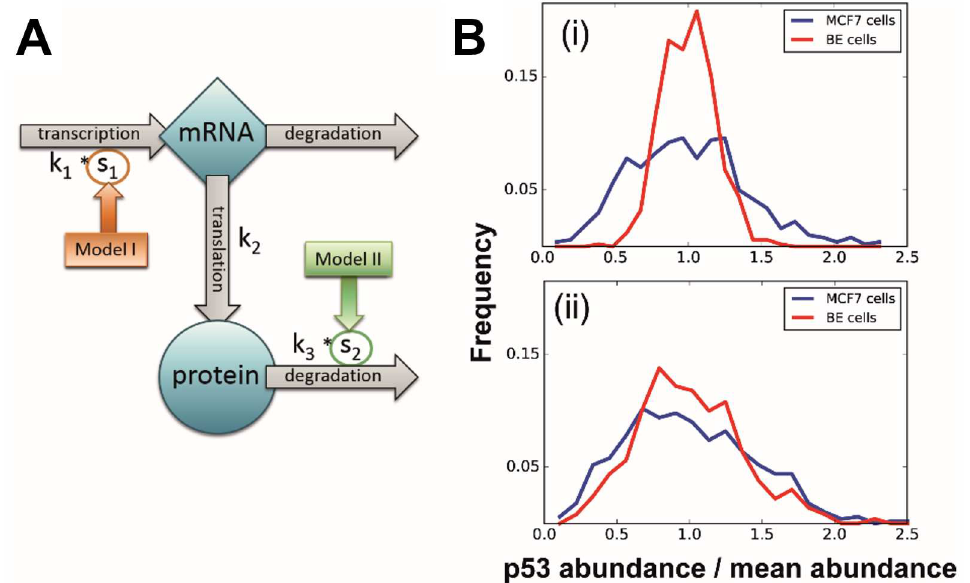
Fig 1. Schematics of the model and simulation examples of regulation strategies. (A) Schematic representation of the model of stochastic p53 protein expression. Blue shapes represent the two species, grey arrows the reactions modelledexplicitlyin our formalisation. Rate parameters corresponding to each reaction ( k 1, k 2, k 3 ) are indicatednext to their respectivereactions; the rate of mRNA degradationis assumed to be 1, and other rates are scaled accordingly. The two competingregulatorymodels are indicatedin dark orangeand green, with arrows pointingout the relevant reaction influenced through a scalingfactor in each model. (B) Comparison of mRNA-level and protein-level regulation.Curves show p53 distribution in cell populations simulatedusing (i) the transcription-based and (ii) the protein degradation-basedmodel. Blue and red distributions represent MCF7 and BE cell line populations, respectively.Protein abundance on the horizontal axis is normalised by mean p53 level to helpcomparison. Note the relative fractional widths in each case.